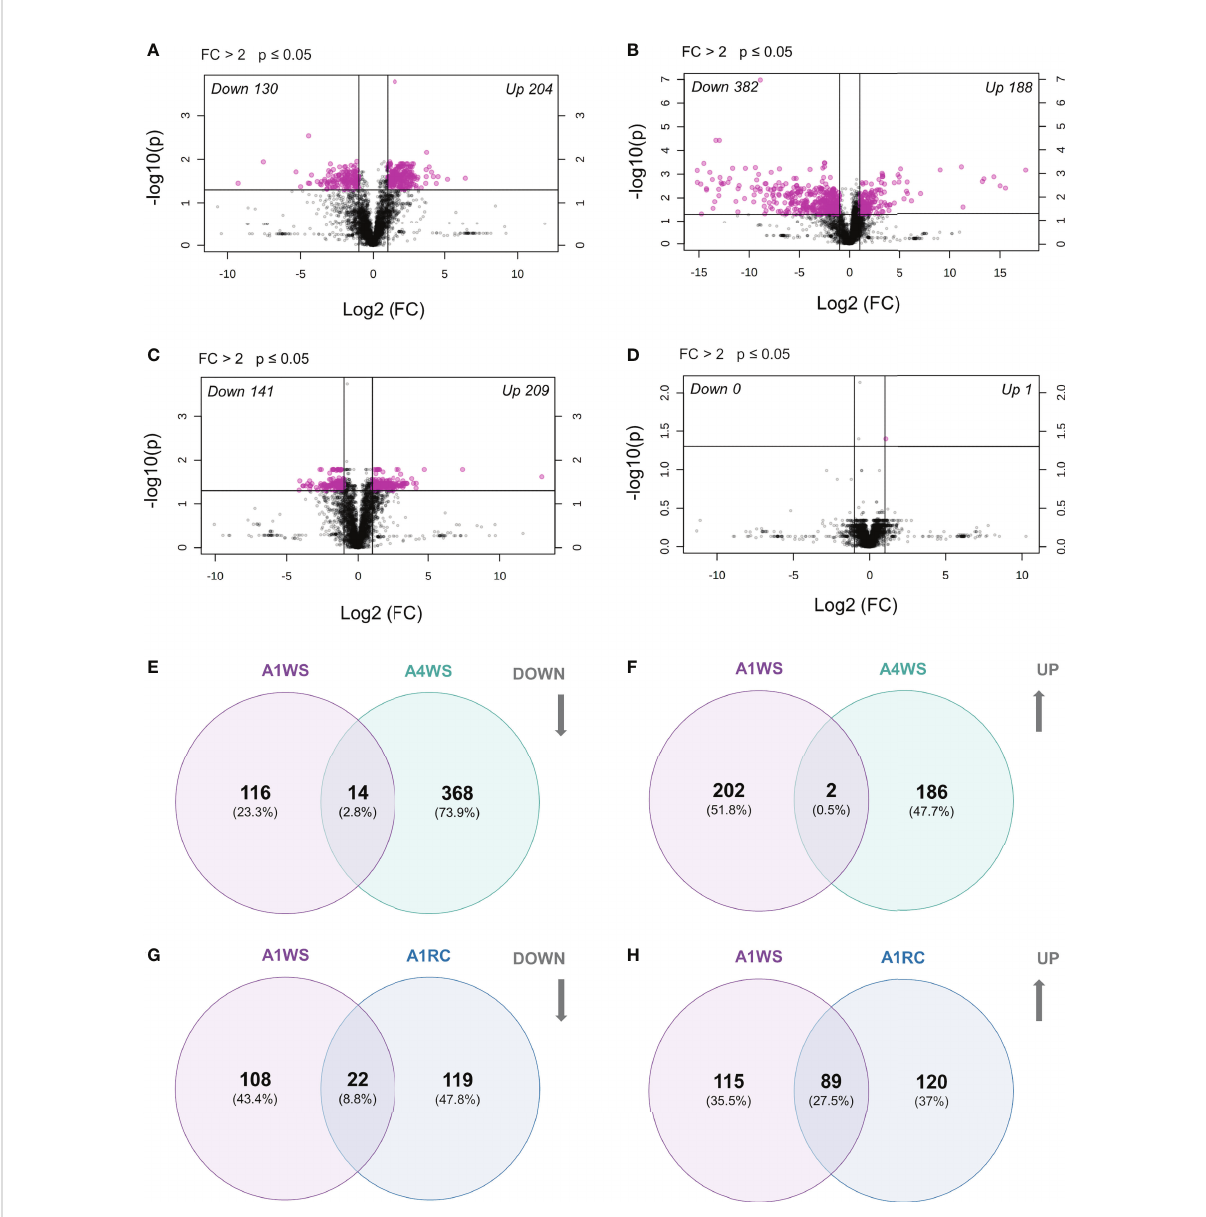
FIGURE 6 Differentially expressed metabolites on t2 (20 days) and t3 (20 + 5 days) on 2 genotypes (A1 and A4) and 3 water regimes (well-watered, water- stress and recover): volcano plot for genotype A1 indicating signi fi cantly (p<0.05 and FC > 2) up- and down-regulated metabolites between treatments on t2 (A) and t3 (B) , volcano plot for genotype A4 indicating signi fi cantly (p<0.05 and FC > 2) up- and down-regulated metabolites between treatments on t2 (C) and t3 (D) , Venn diagram with the down-regulated metabolites shared between genotype A1 and A4 on water- stress treatments (E) , Venn diagram with the up-regulated metabolites shared between genotype A1 and A4 on water-stress treatments (F) , Venn diagram with the down-regulated metabolites shared between recover and water-stress treatments on genotype A1 (G) , Venn diagram with the up-regulated metabolites shared between recover and water-stress treatments on genotype A1 (H) . Data was normalised by median, cube root transformed and Pareto-scaled (n =